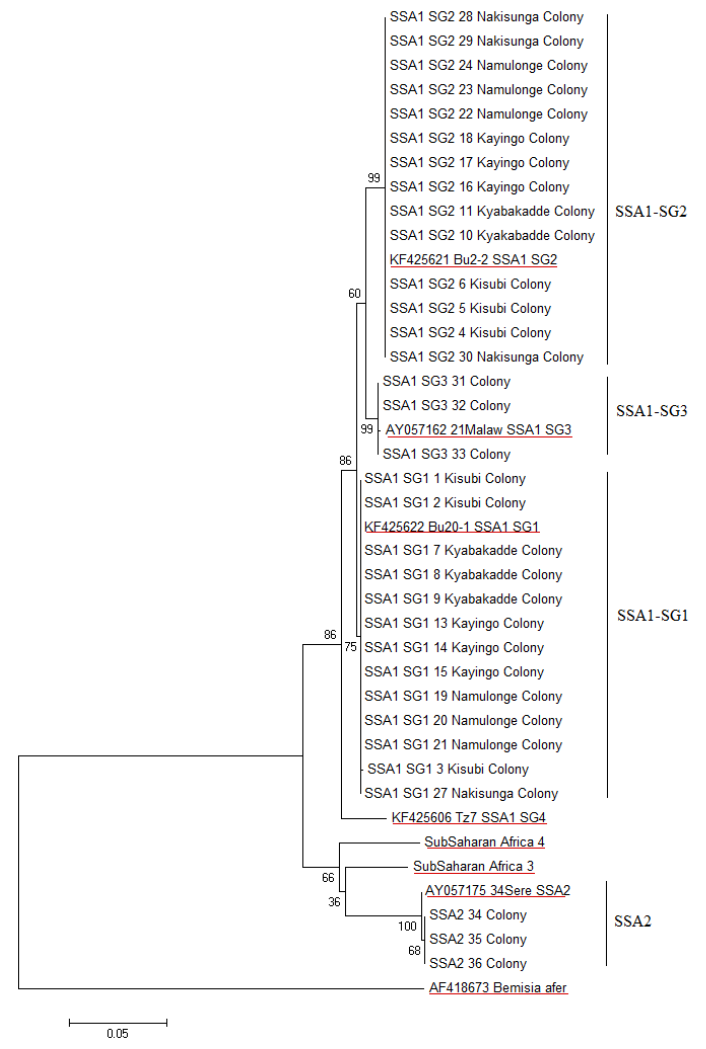
Figure 1. Maximum Parsimony phylogeny reconstruction based on partial mtCO1 sequences (657 bp) of individual Bemisia tabaci collected from colonies established at the Natural Resources Institute (NRI). The location of collection of individual B. tabaci SSA1-SG1 and SSA1-SG2 in Uganda is denoted in the sequence name. Individual B. tabaci 31–33 were collected from the SSA1-SG3 colony established from Dar es Salaam (Tanzania). Individual B. tabaci 34–36 were collected from SSA2 colony established from Kiboga (Uganda). Underlined are reference sequences from Legg et al. [4]. B. afer was used as an outgroup.